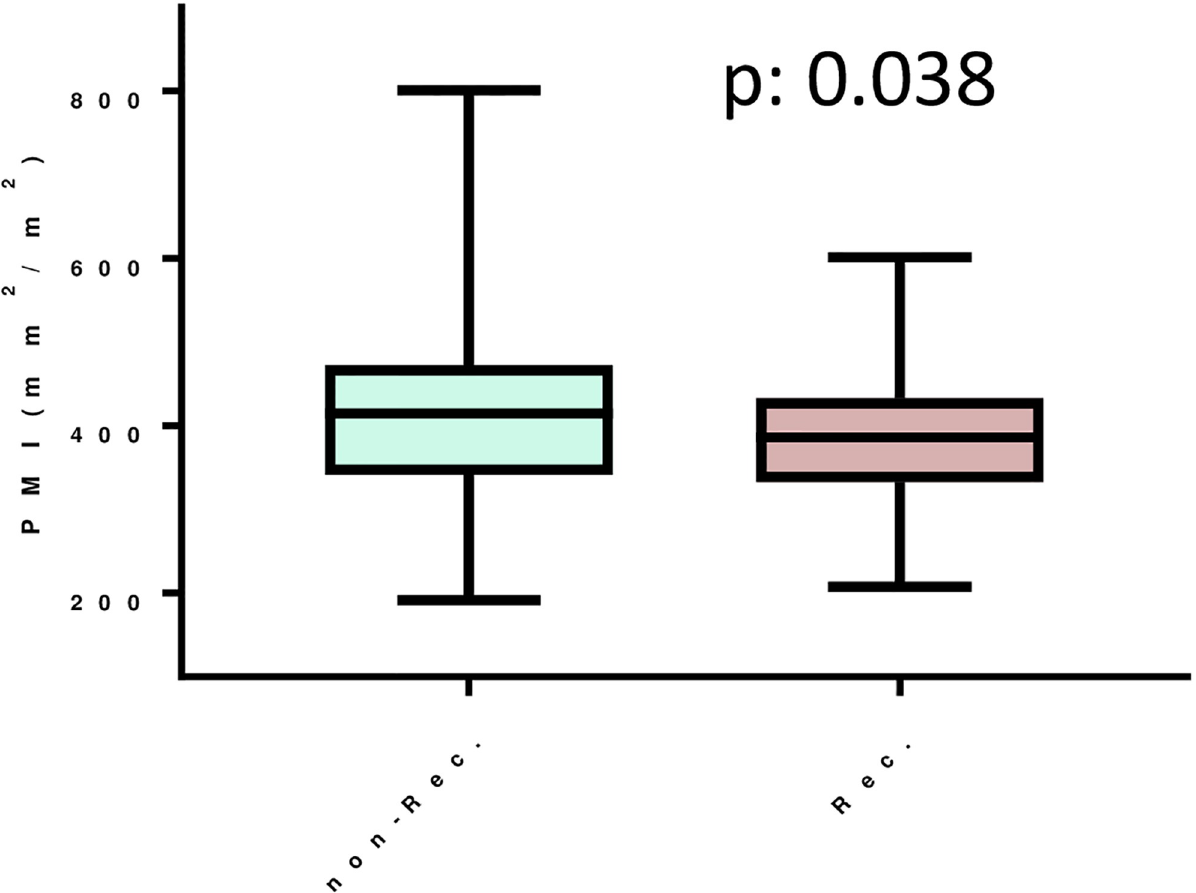
Fig 4. PMI in non-recurrent and recurrent patients.